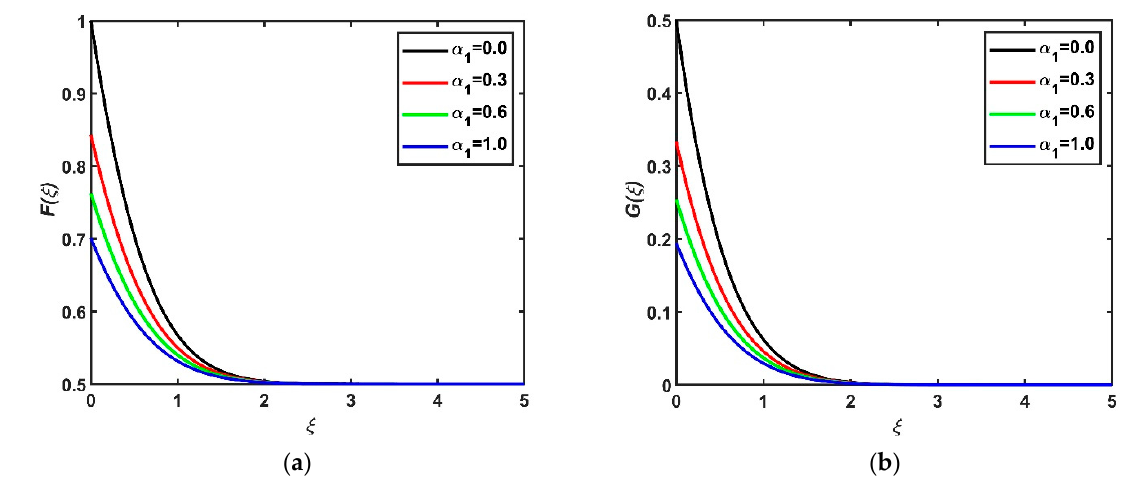
Figure 6. Impact of 𝜔 on ( a ) 𝐹(𝜉) and ( b ) 𝐺(𝜉) .